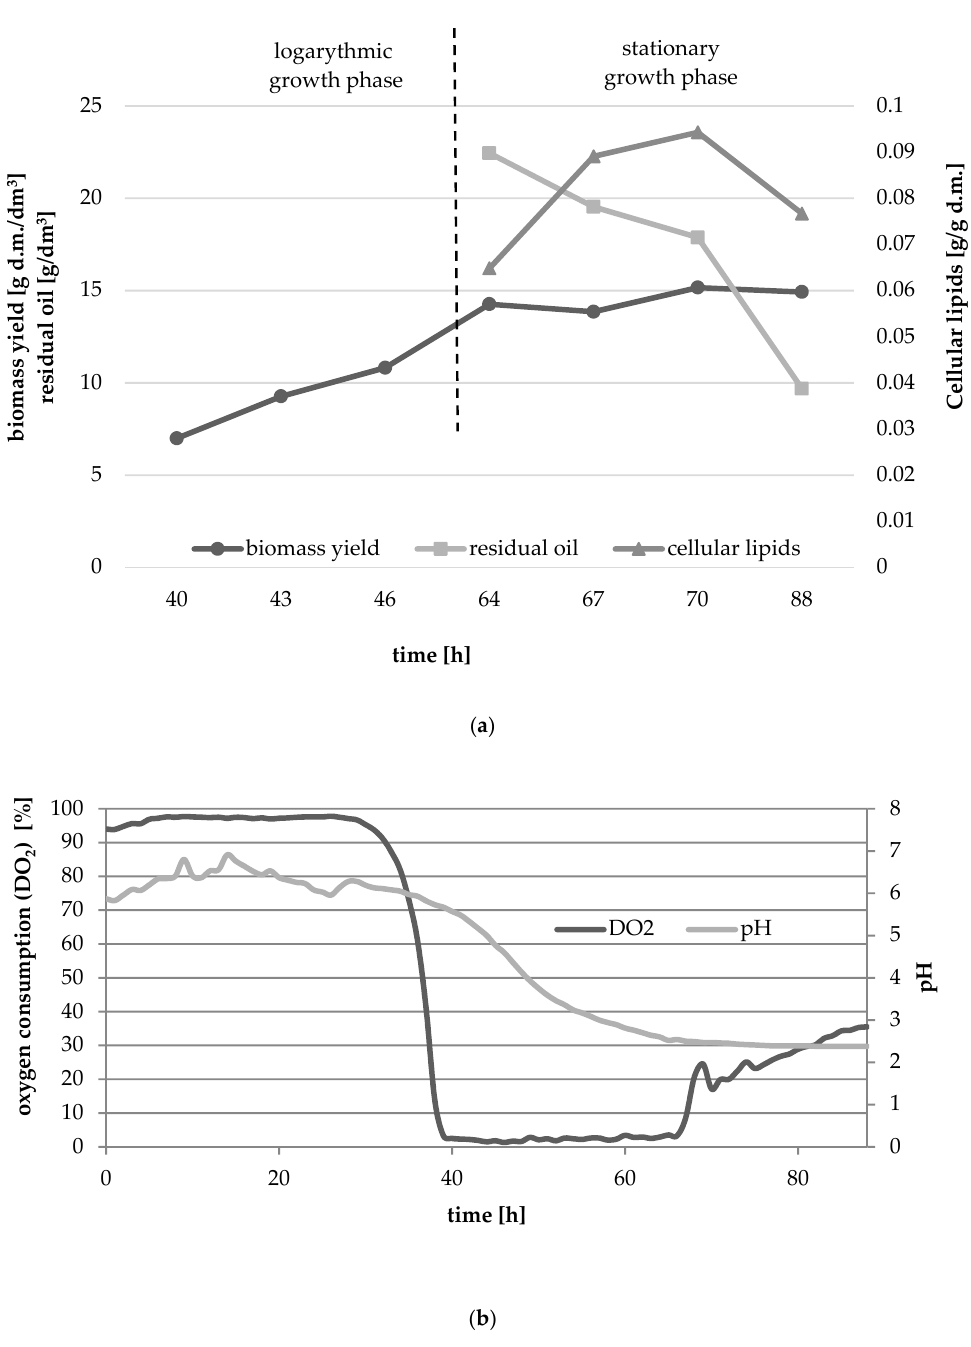
Figure 1. Changes in biomass yield and the content of cellular lipids ( a ), relative oxygen consumption and pH ( b ) of the yeast strain Y. lipolytica KKP 379 grown in MF5 medium with waste fish oil as a carbon source.